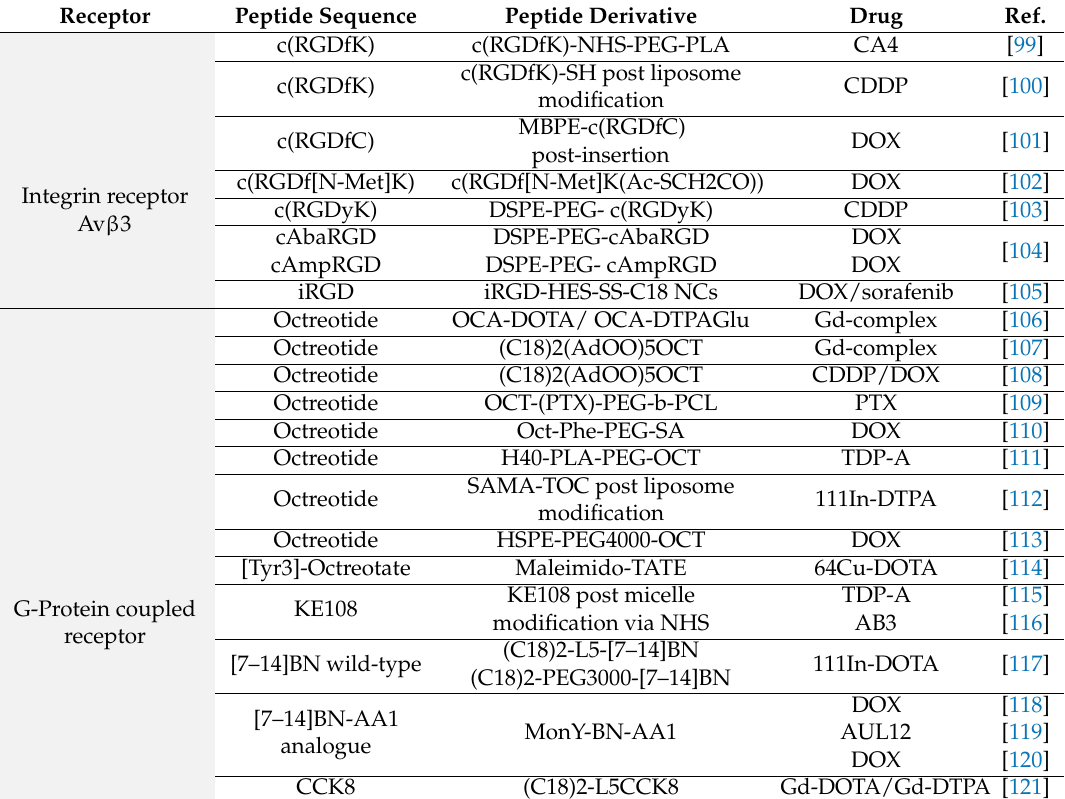
Table 1. Supramolecular systems decorated with homing peptides able to selectively recognize integrin receptors or membrane receptors belonging to the GPCR superfamily. The bioactive peptide, the peptide conjugation, the encapsulated API, and the corresponding references are